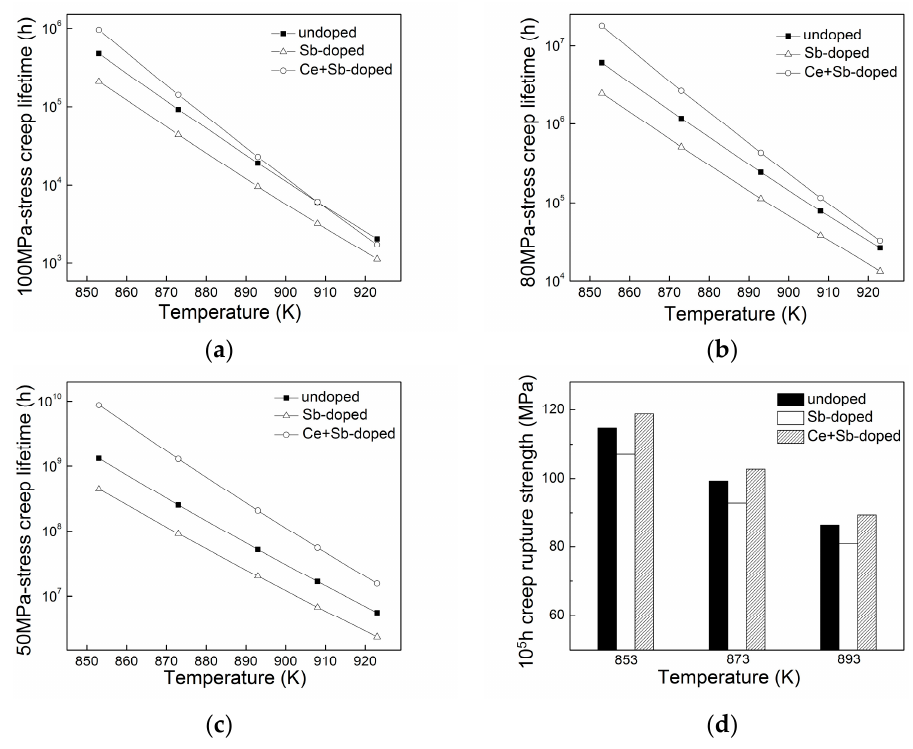
Figure 2. ( a ) 100 MPa ‐ stess creep lifetime; ( b ) 80 MPa ‐ stess creep lifetime; ( c ) 50 MPa ‐ stess creep lifetime; and ( d ) 10 5 h creep rupture strength of the steels at 853 K, 873 K, and 893 K for the undoped, Sb ‐ doped, and Sb+Ce ‐ doped steels.